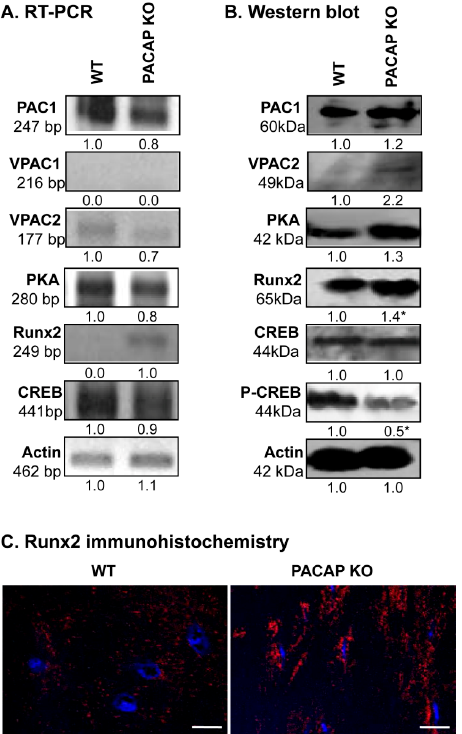
Figure 4. PACAP signalisation in bones. ( A ) mRNA and ( B ) protein expression of pituitary adenylate cyclase-activating polypeptide type I receptor (PAC1), vasoactive intestinal polypeptide receptor (VPAC)1, VPAC2,protein kinase A (PKA), cyclic adenosine monophosphate (cAMP) response element-binding protein (CREB), Runx2 in cortical bone. Actin was used as a control. Numbers below signals represent integrated signal densities determined by ImageJ software. Asterisks indicate significant (* p < 0.05) alteration of expression compared to the respective controls. Representative data of 3 independent experiments. ( C ) Immunohistochemistry of Runx2 in cortical bones. Original magnification was 60 × . Scale bar: 5 µ m. Representative data of 3 independent